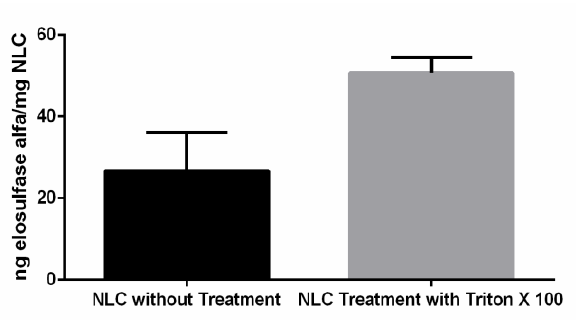
Figure 3. Activity of elosulfase alfa immobilized in the NLC before and after the complete disintegration of particles.